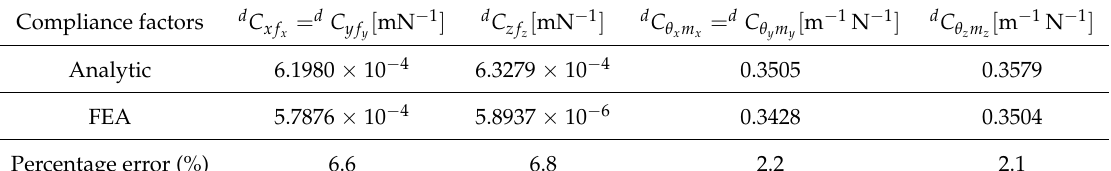
Table 1. Compliance factors for the spherical joint and comparison between analytical and FEA results Compliance factors